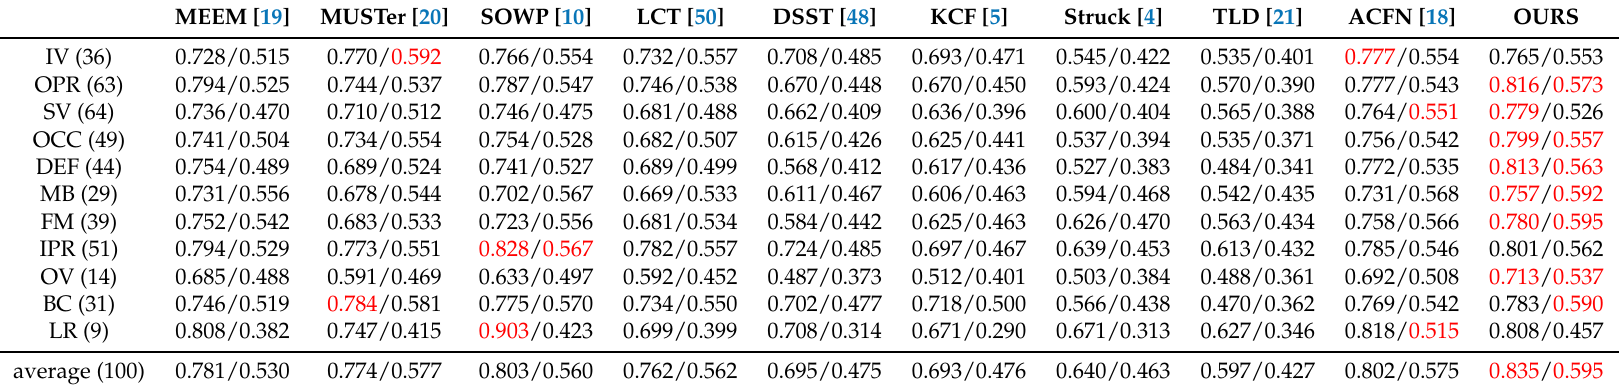
Table 1. The PR/SR scores of our tracker and recent state-of-the-art trackers on the 11 challenging factors: illumination variation (IV), out-of-plane rotation (OPR), scale variation (SV), occlusion (OCC), deformation (DEF), motion blur (MB), fast motion (FM), in-plane rotation (IPR), out-of-view (OV), background clutters (BC) and low resolution (LR). The red number is the best result.